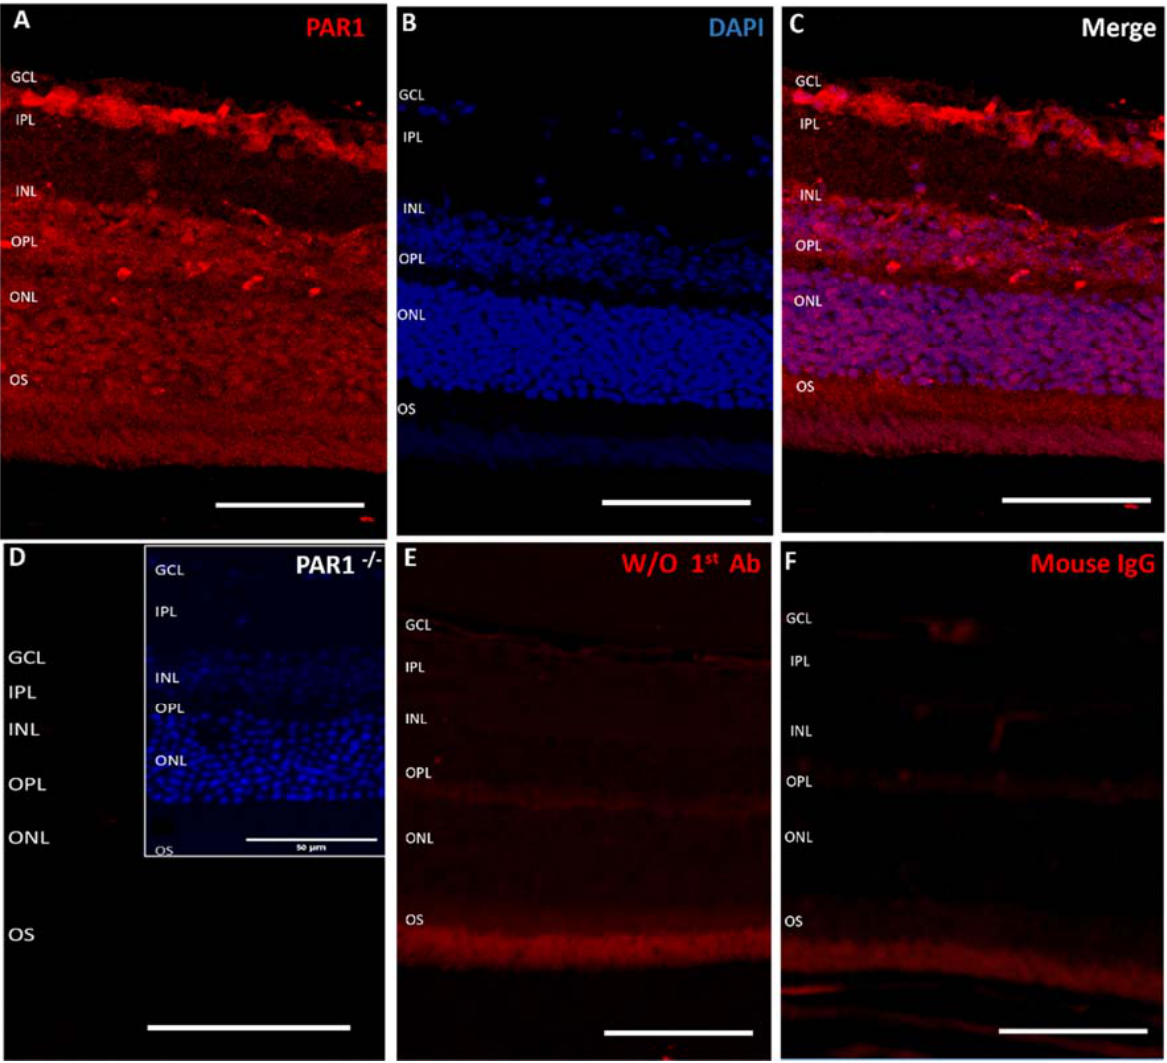
Figure 1. PAR1 expression in mouse neuroretina. Paraffin retinal cross sections derived from C57BL/6J mice, ( A – C , E , F , n = 12) and PAR1 − / − mice (n = 2) ( D ) were stained with anti ‐ PAR1 antibody (red, A , C , D ), secondary antibody only, ( E ) and commercial mouse IgG ( F ) as controls and were counter ‐ stained with 4 ′ ,6 ‐ diamidino ‐ 2 ‐ phenylindole (DAPI, blue, B , D ‐ insert). Insert in panel D: the insert demonstrates DAPI staining of this section. Scale bars: 50 μ m. GCL: ganglion cell layer, IPL: inner plexiform layer, INL: inner nuclear layer; OPL: outer plexiform layer, ONL: outer nuclear layer, OS: (photoreceptor) outer segments.